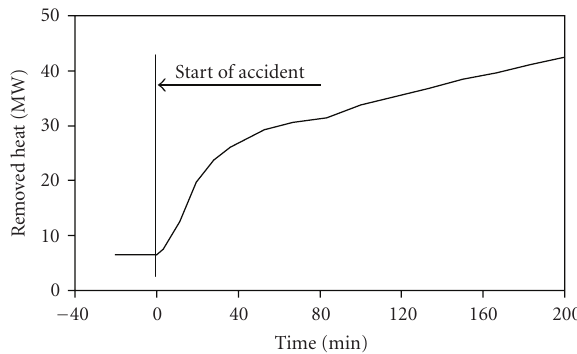
Figure 16: MCP pressure header break with failure of ECCS. Heat removal from fuel channels through 211 CPS channels by CPS cooling